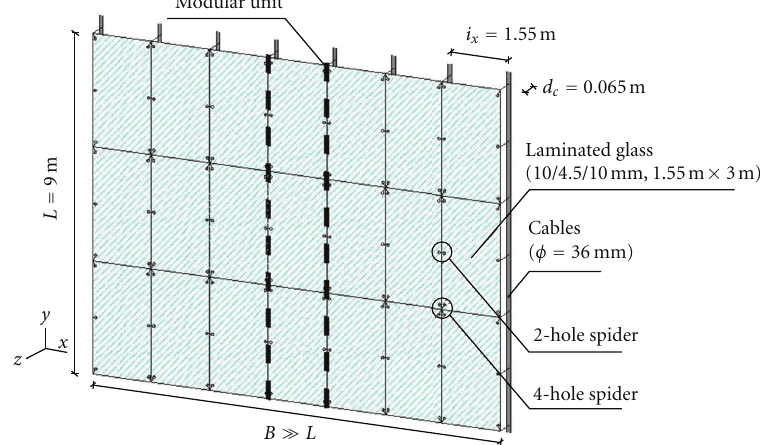
Figure 1: Schematic rendering of the studied cable-supported fac¸ade.